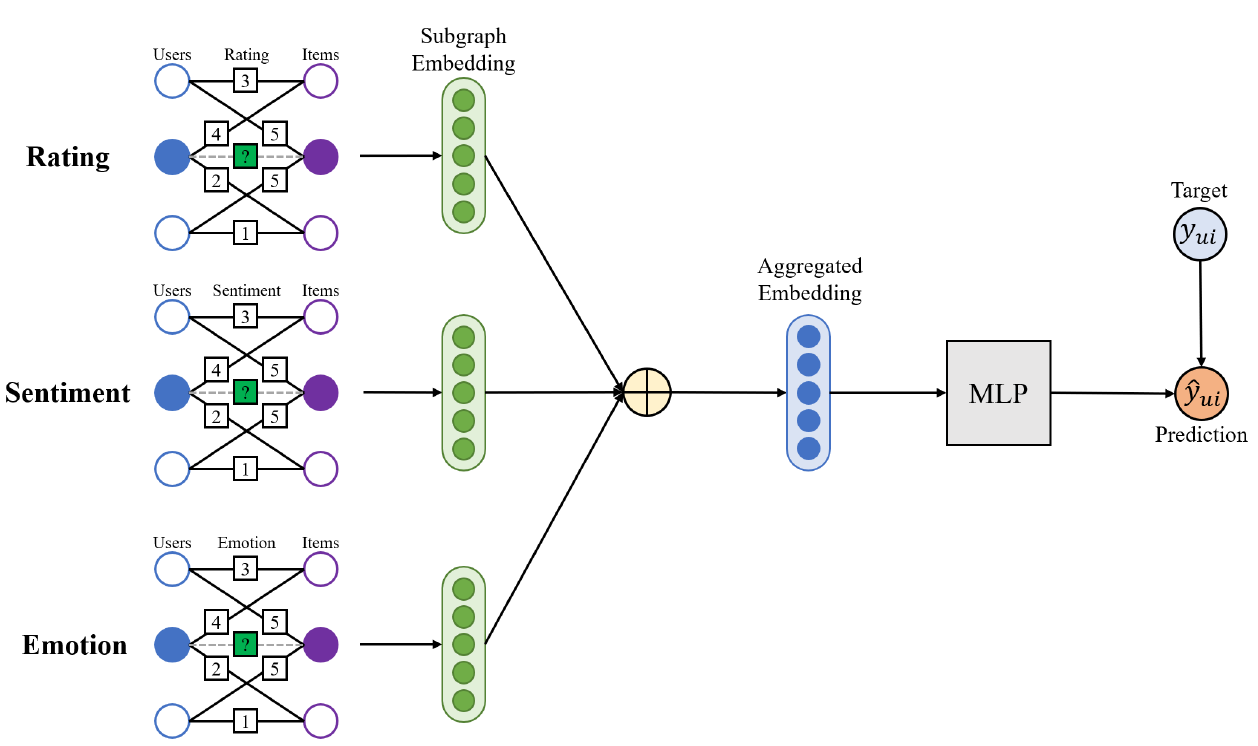
Figure 2. Overview of the proposed framework.